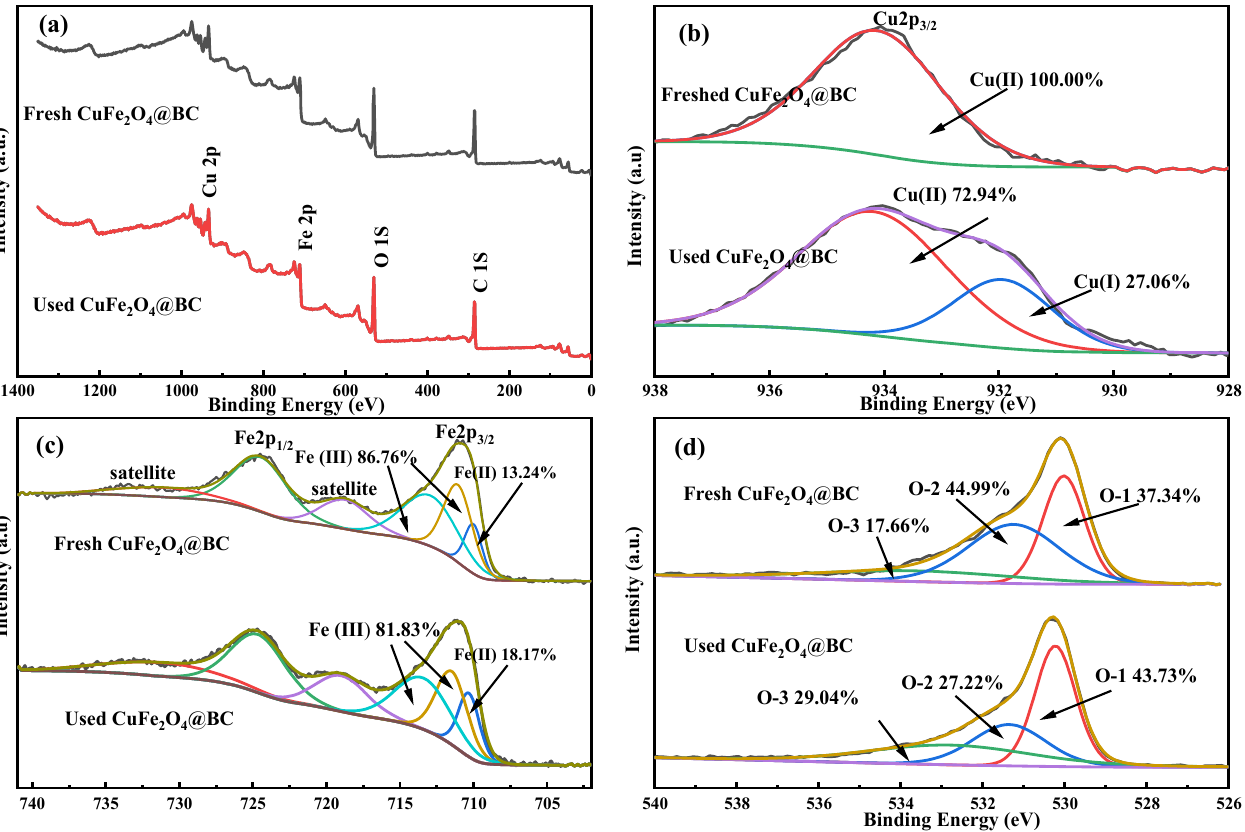
Figure 3. XPS spectroscopy wide scan ( a ) Cu 2p, ( b ) Fe 2p, ( c ) and O 1s, ( d ) of the fresh and used CuFe 2 O 4 @BC catalysts.